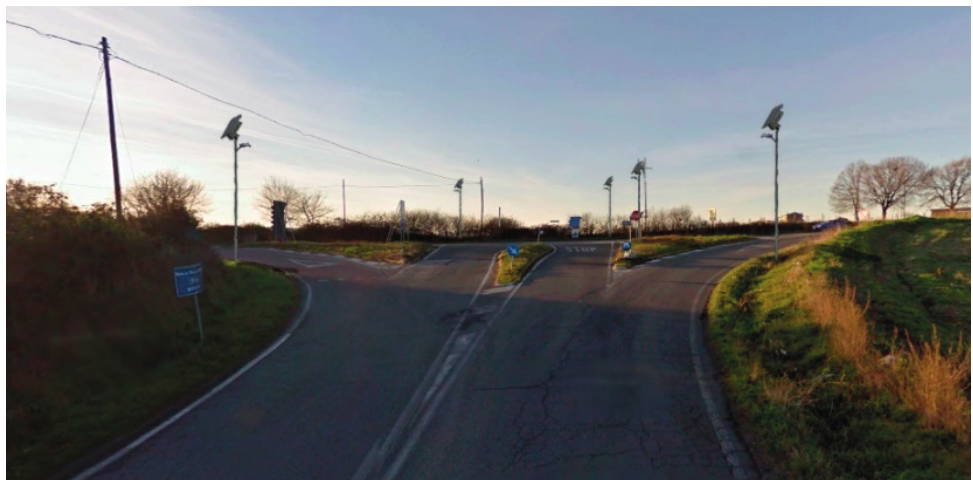
Figure 6. Test system in the